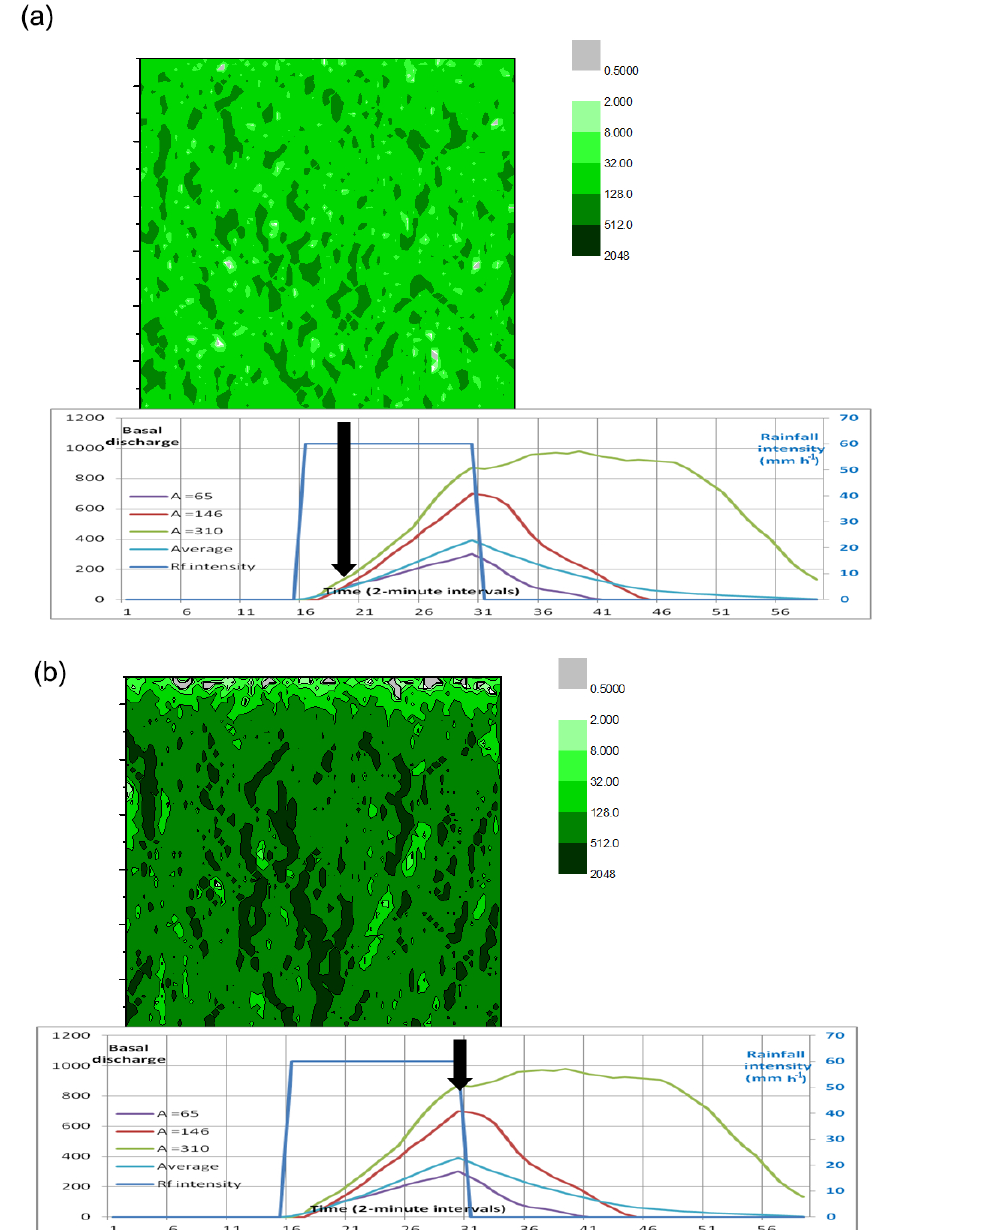
Figure 3. Modelled evolution of runoff patterns on randomly rough slope of 160 × 160m. Individual hydrographs are shown for points on the lower boundary with different catchment areas, parts of the total area of 4096 (64 × 64). Square shows intensity (on log scale) of local overland flow at a time indicated by the heavy arrows on the hydrographs below. (a) Early in a 30mm, 30min storm, runoff generated in patches of lowest infiltration capacity. (b) As storm rainfall ends, downslope accumulation defines connectivity along strongest flow